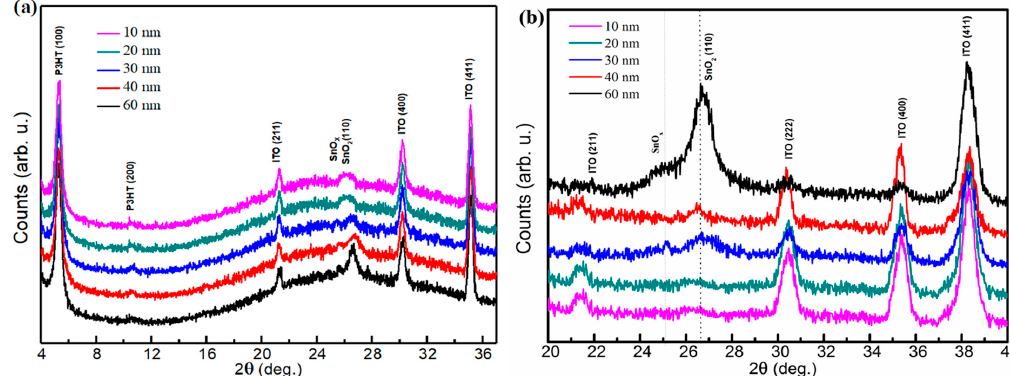
Figure 5. XRD ( a ) and GIXRD ( b ) patterns of all device glass / ITO / SnO 2 / PEIE / P3HT:PCBM / MoO 3 / Ag structures with di ff erent thicknesses of SnO 2 (10, 20, 30, 40, 60 nm).